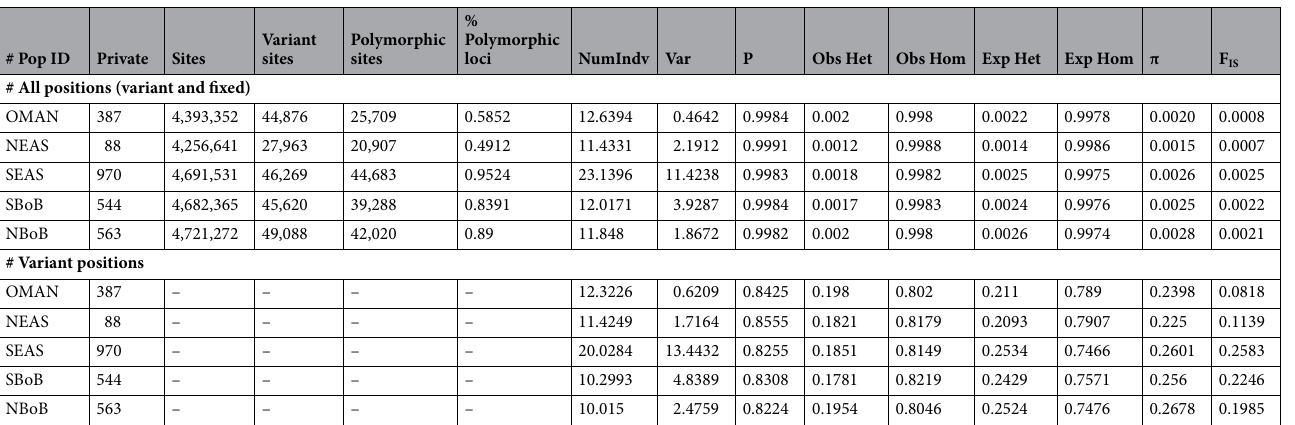
Table 1. Summary of Genetic diversity statistics for restriction-site associated DNA (RAD) sites of S. longiceps . Population ID (Pop ID), the number of variable sites unique to each population (Private), the number of nucleotide sites across the data set (Sites), polymorphic sites across the data set (Polymorphic Sites), percentage of polymorphic loci (% polymorphic loci), the average number of individuals genotyped at each locus (NumIndv), variance (Var), the average frequency of the major allele (P), the average observed heterozygosity per locus (Obs Het), the average observed homozygosity (Obs Hom), the average expected heterozygosity (Exp Het), the average expected homozygosity (Exp Hom), the average nucleotide diversity (π) and Average Wright’s inbreeding coefficient (F IS ).